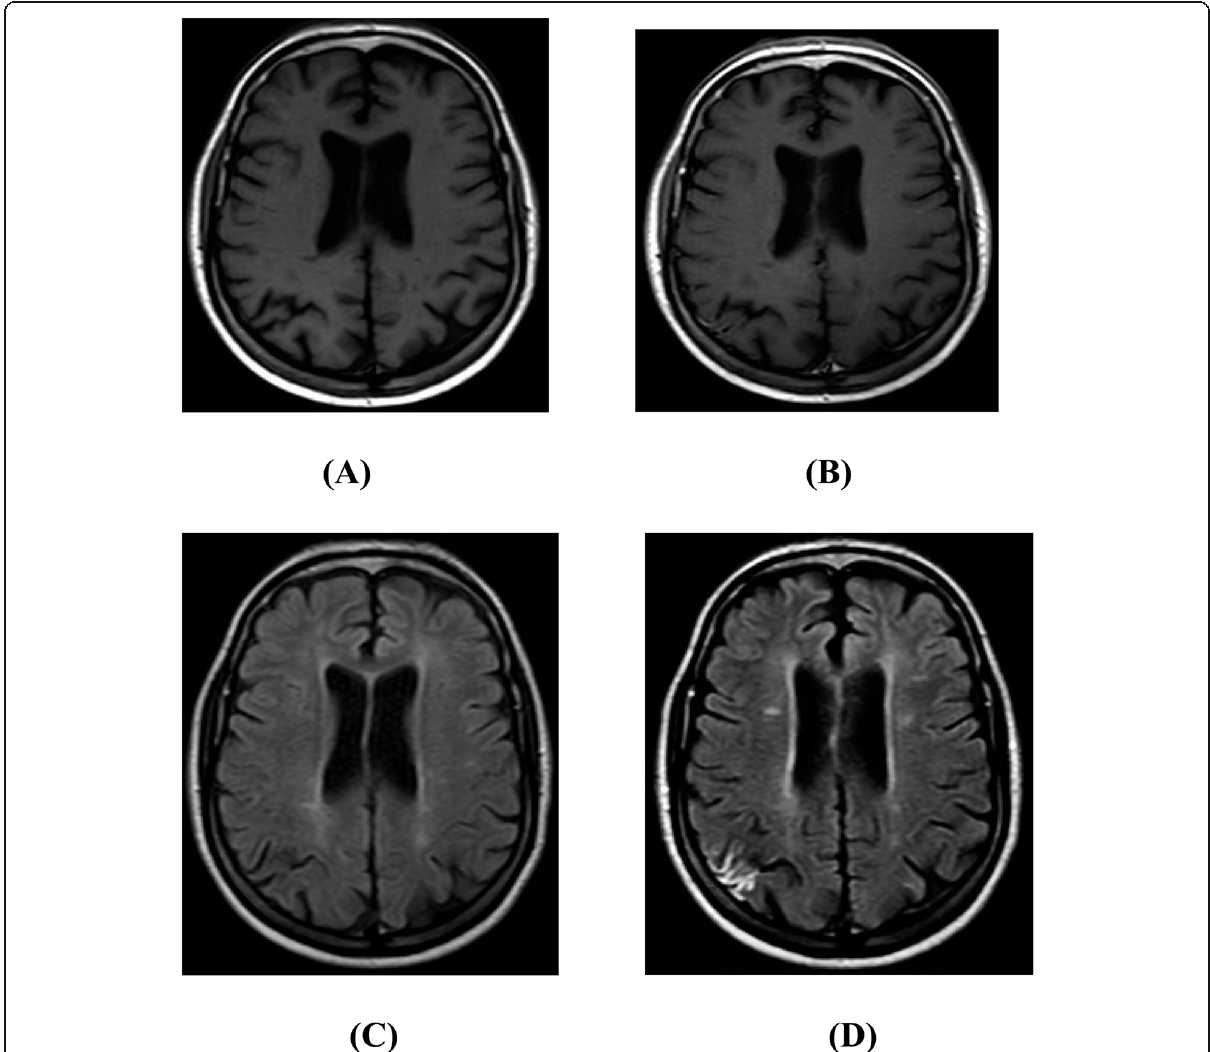
Fig. 1 Female patient aged 36 years, known case of multiple sclerosis on follow up, presented by clinical signs of activity. A , B Axial pre and post- contrast T1WI respectively showed no definite lesions. C Axial pre-contrast FLAIR showed few foci of high signal intensity at periventricular white matter. D Axial post-contrast FLAIR showed nodular enhancement of MS plaques (arrows) and gyriform enhancement at left parietal lobe was better demonstrated than in post-contrast T1W